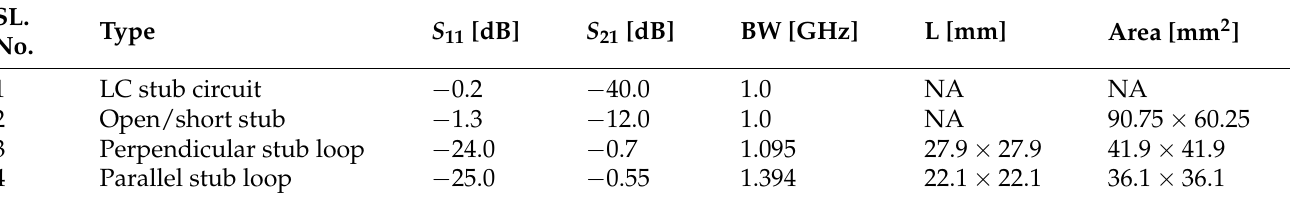
Table 3. Band pass filters comparisons; ε r = 4.0, h = 1.6 mm.